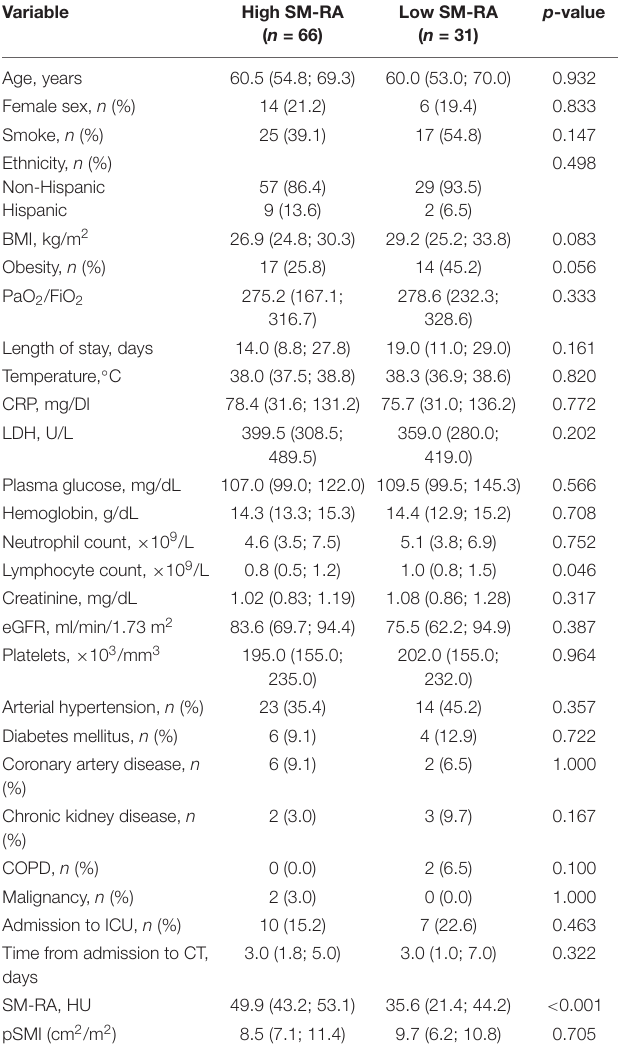
TABLE 2 | Comparison between patients with (low SM-RA) or without (high SM-RA) myosteatosis at 6 months after discharge.